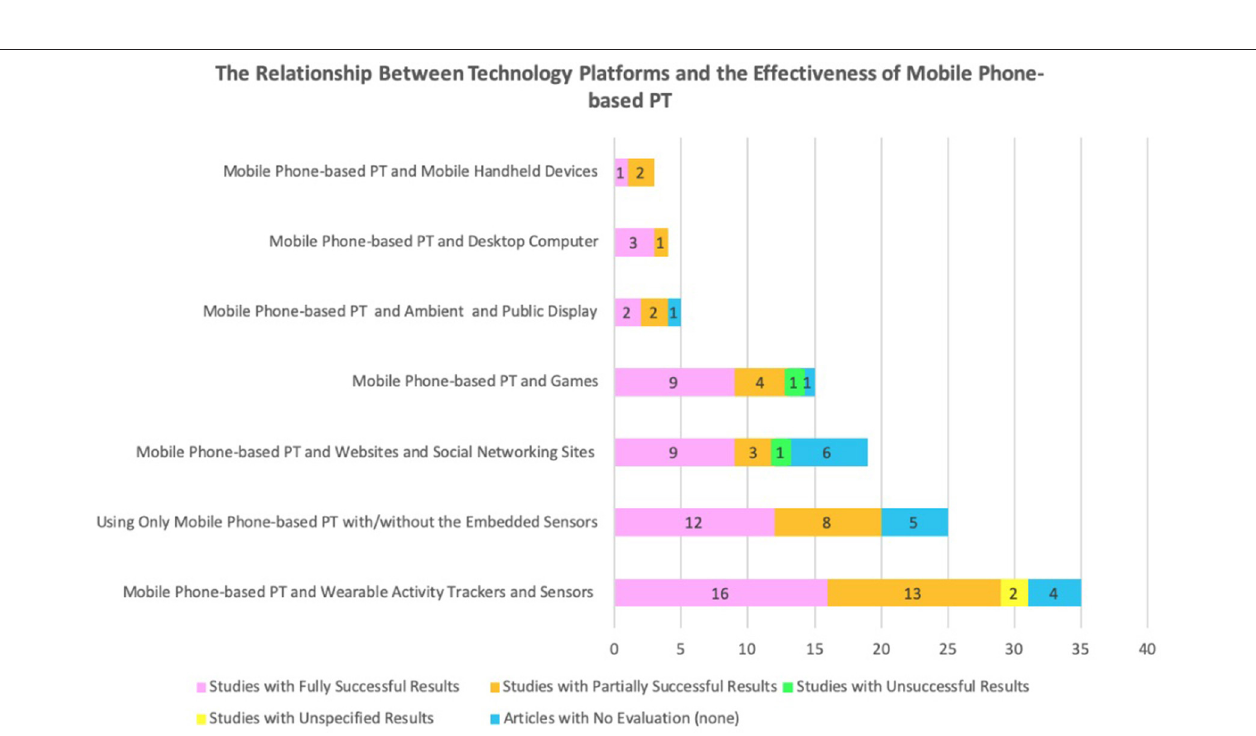
FIGURE 6 | The relationship between technology platforms and effectiveness of mobile phone-based persuasive technologies (PTs).